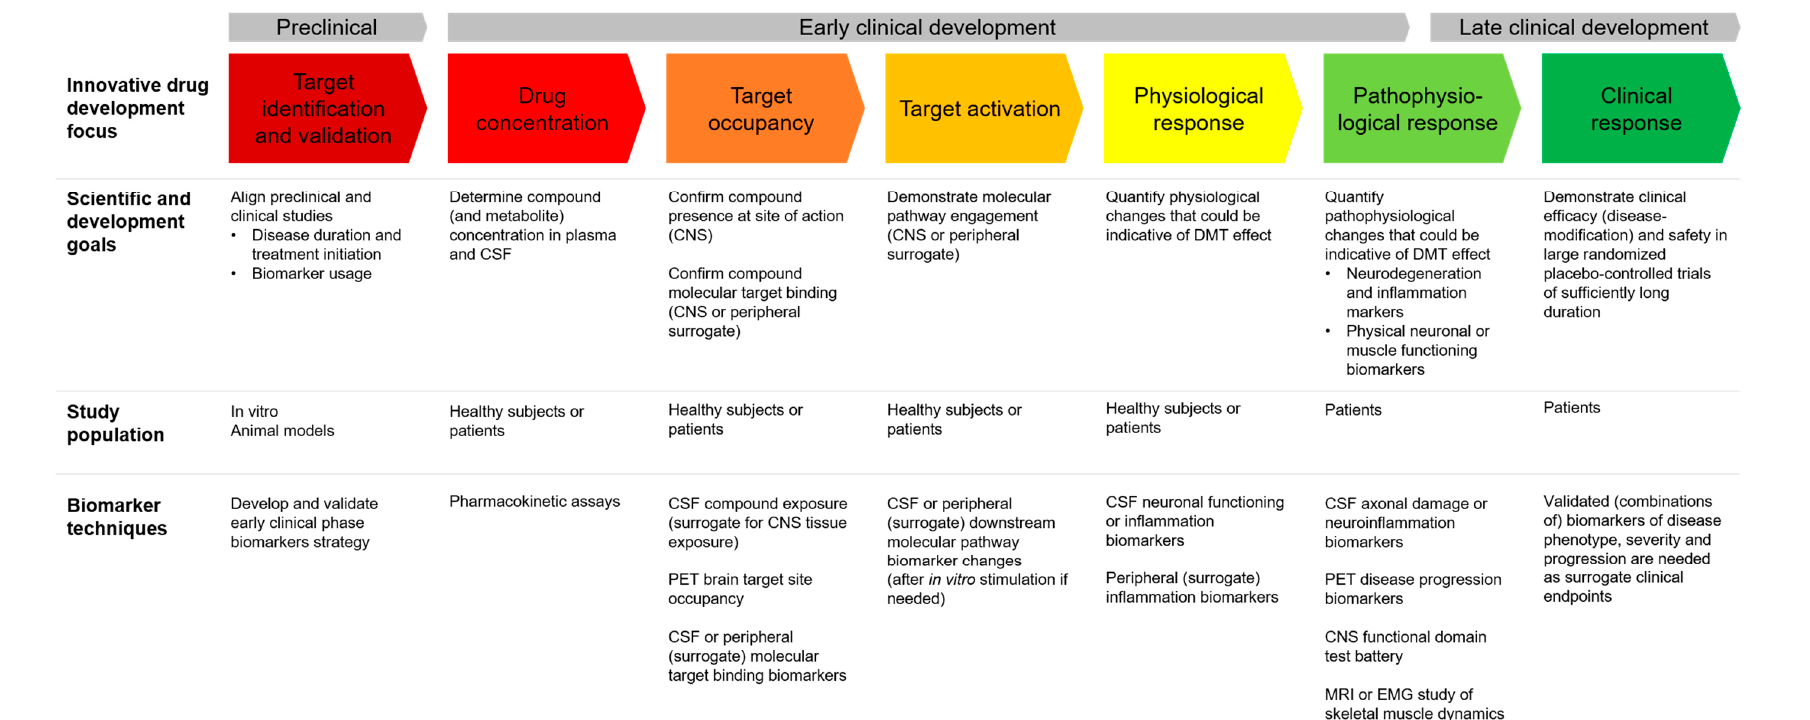
Figure 2. Roadmap for early phase clinical development of disease-modification therapies in neurodegenerative disorders, focusing on demonstrating proof-of-concept with